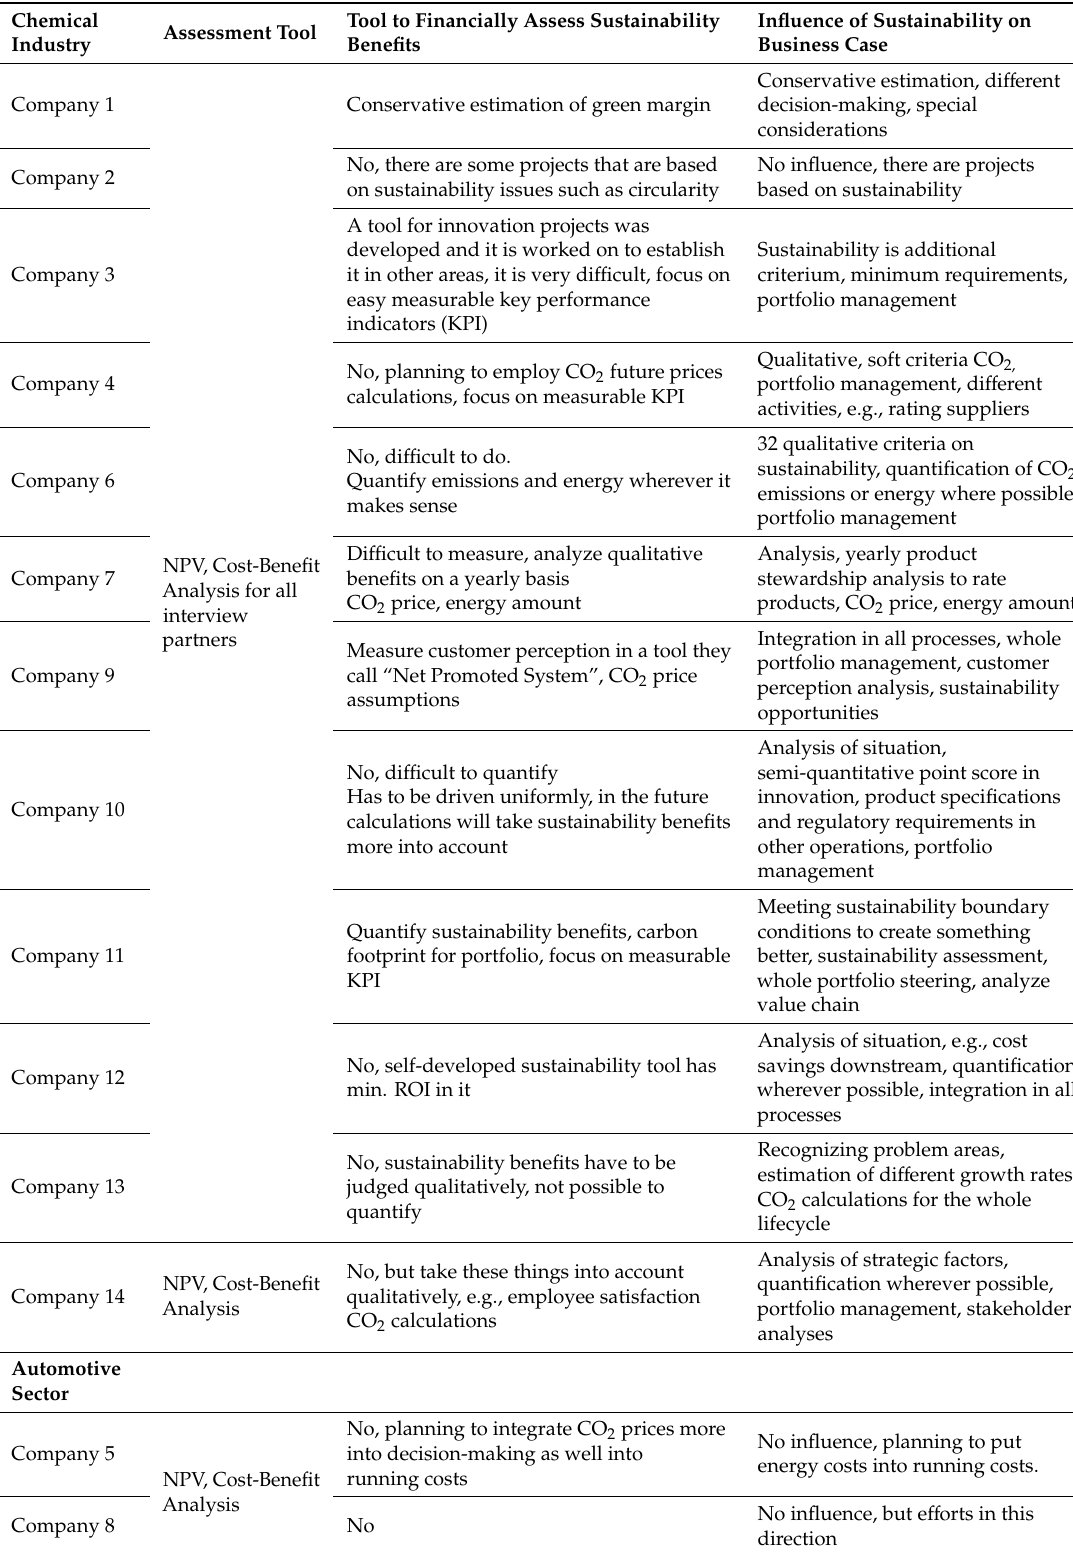
Table 8. Results of question 11 related to currently employed project assessment tools, financial assessments of sustainability and the integration of sustainability into business case